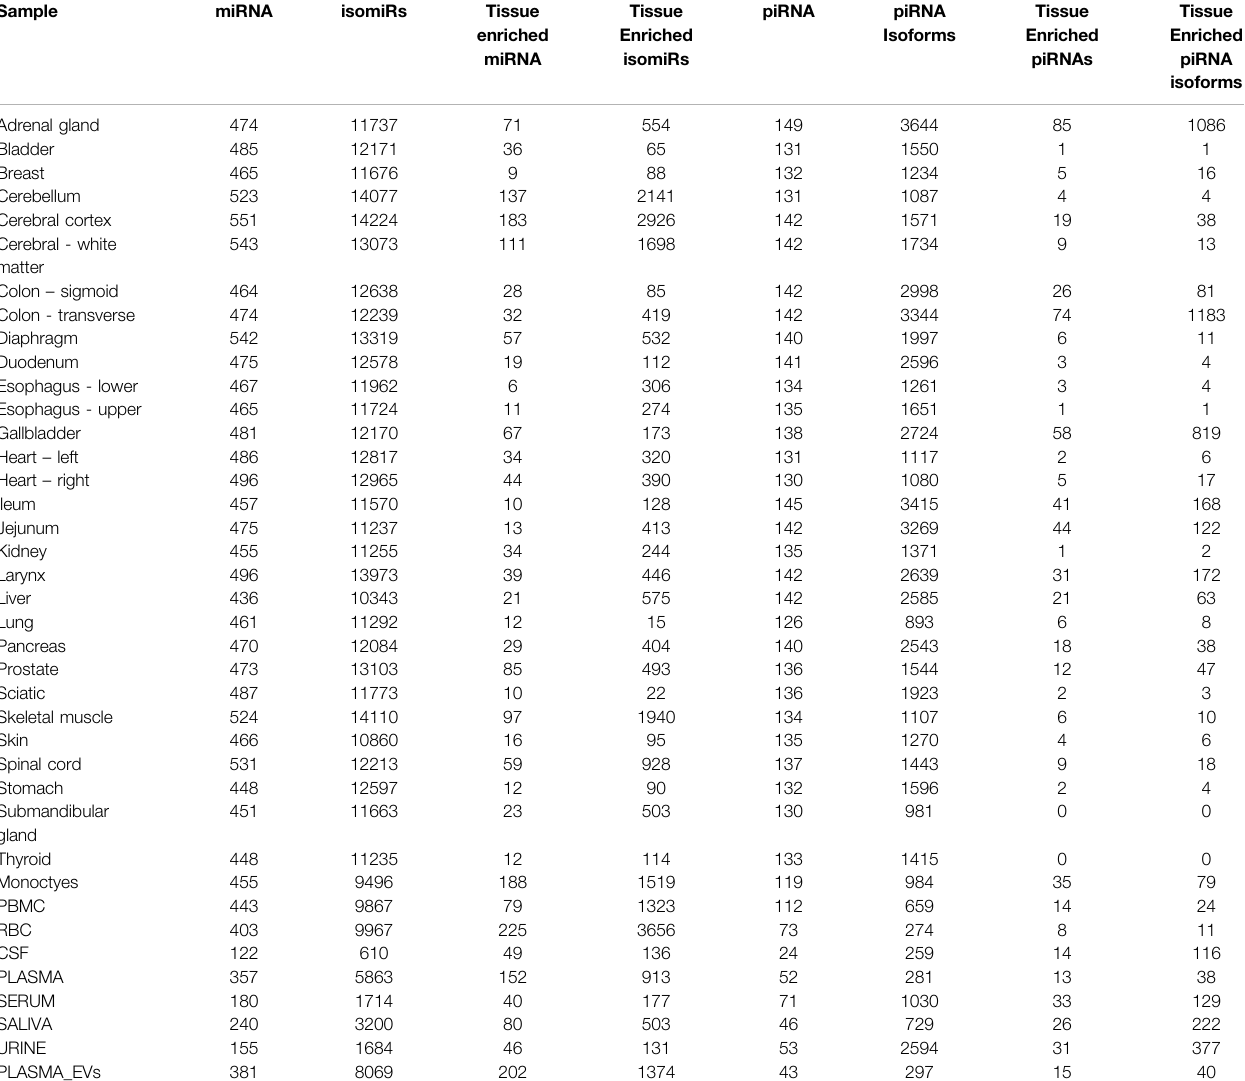
TABLE 1 | Tissue-Enriched Sequences. Displays the # of select RNA biotypes detected, the number of isoforms detected, and the number of tissue-enriched sequences observed for each